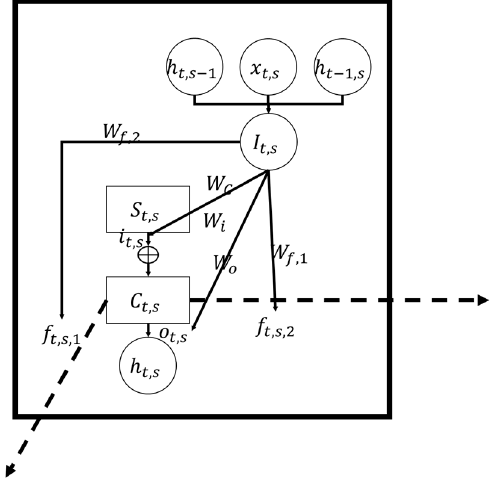
Figure 8. The structure of MDLSTM cell. Arrows in the figure shows the linear transformation from the variable behind the arrow to the variable in front of the arrow.